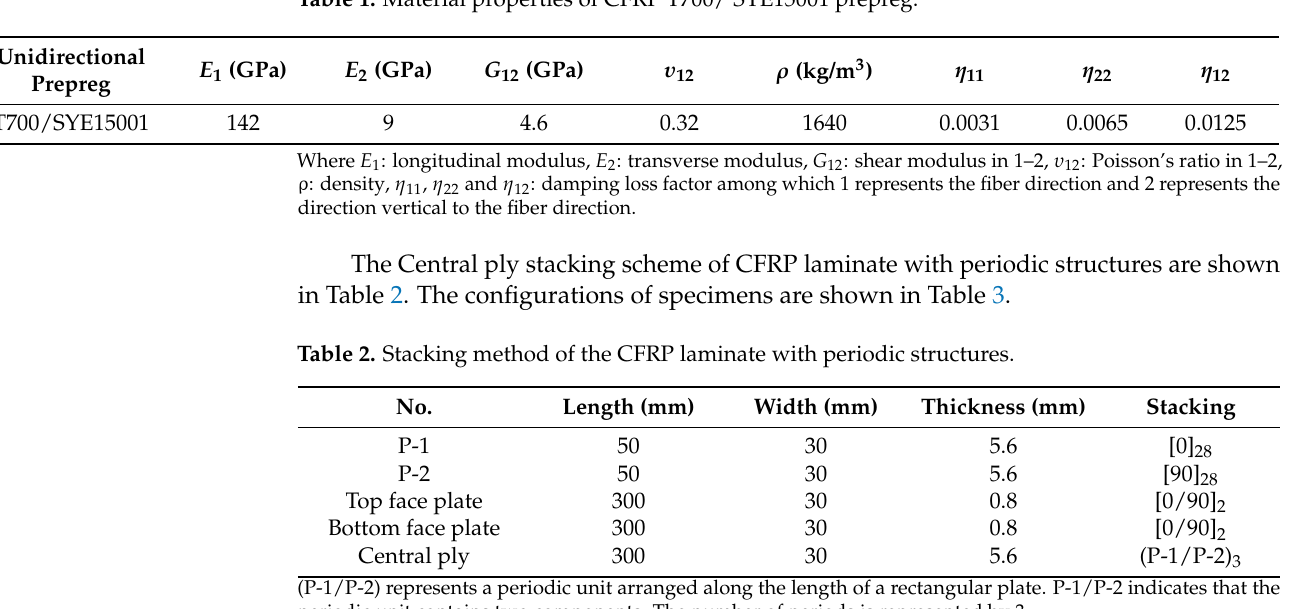
Table 1. Material properties of CFRP T700/ SYE15001 prepreg.